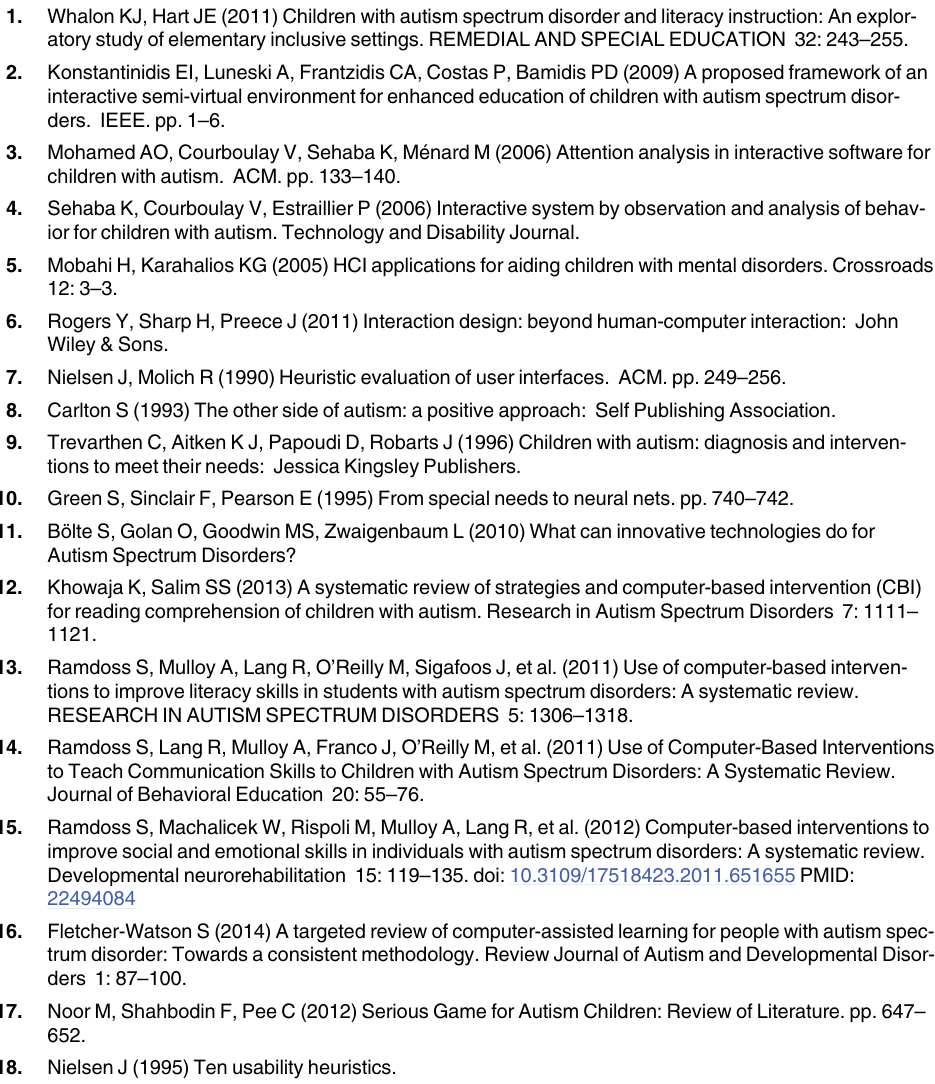
S4 Table. Measure of Agreement (Kappa) for experts ’ pairs with their p-value. S5 Table. Intra-class Correlation Coefficient (ICC) results. S6 Table. Estimated marginal means between severity level and heuristics